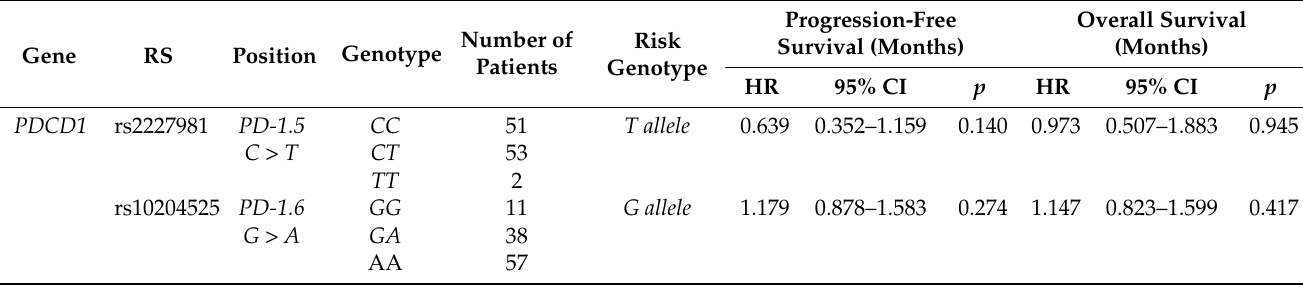
(Table 4), these significances disappeared with the multi-valuable analysis (Table S2). Table 2. Association between survival outcome and PDCD1 polymorphism.